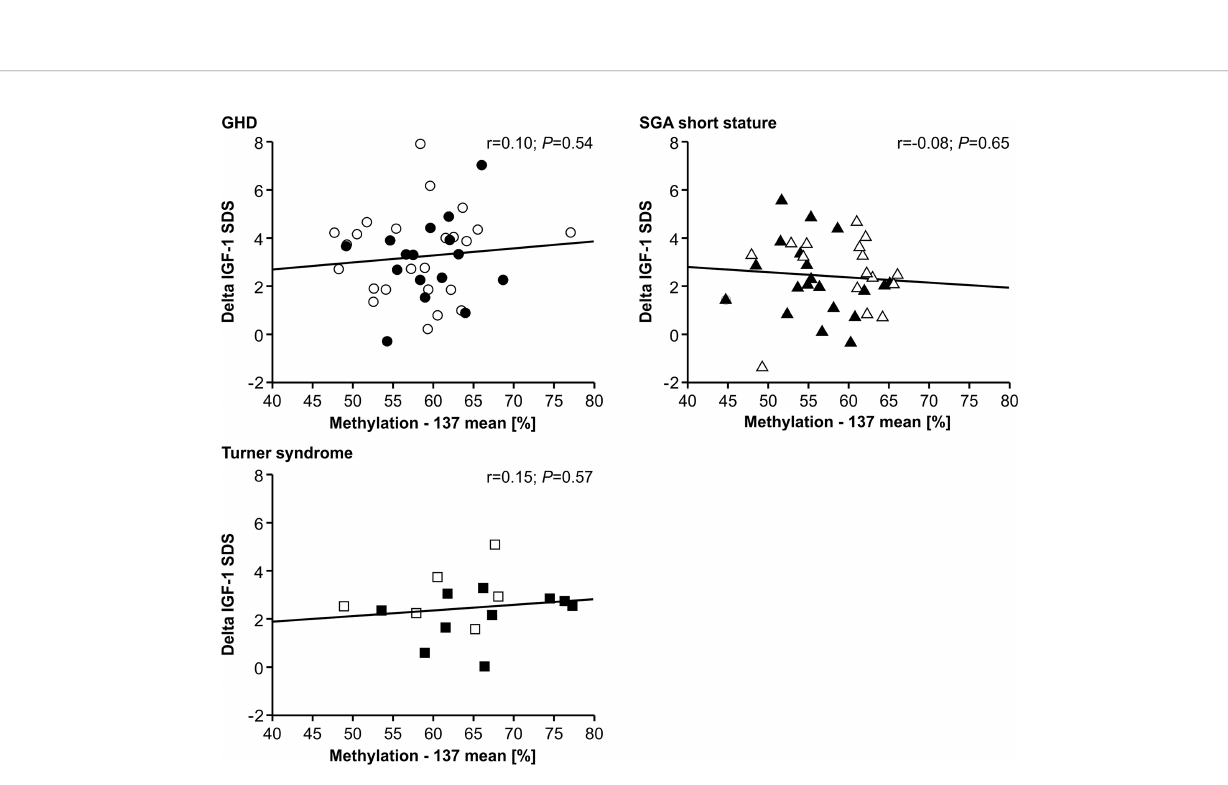
FIGURE 5 | GH-induced increment in IGF-1 SDS (Delta IGF-1 SDS) and IGF1 P2 methylation at position -137. Filled symbols indicate patients with exon3-deleted GHR